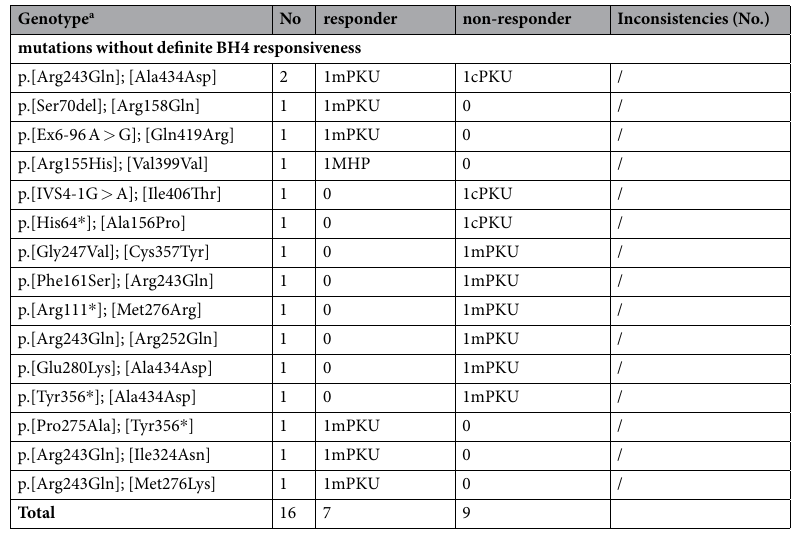
Table 2. Genotype versus BH4 response in 94 Chinese PAH Deficient patients. a The genotypes are described at protein